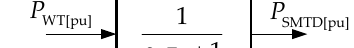
Figure 5. Varying transfer function block.